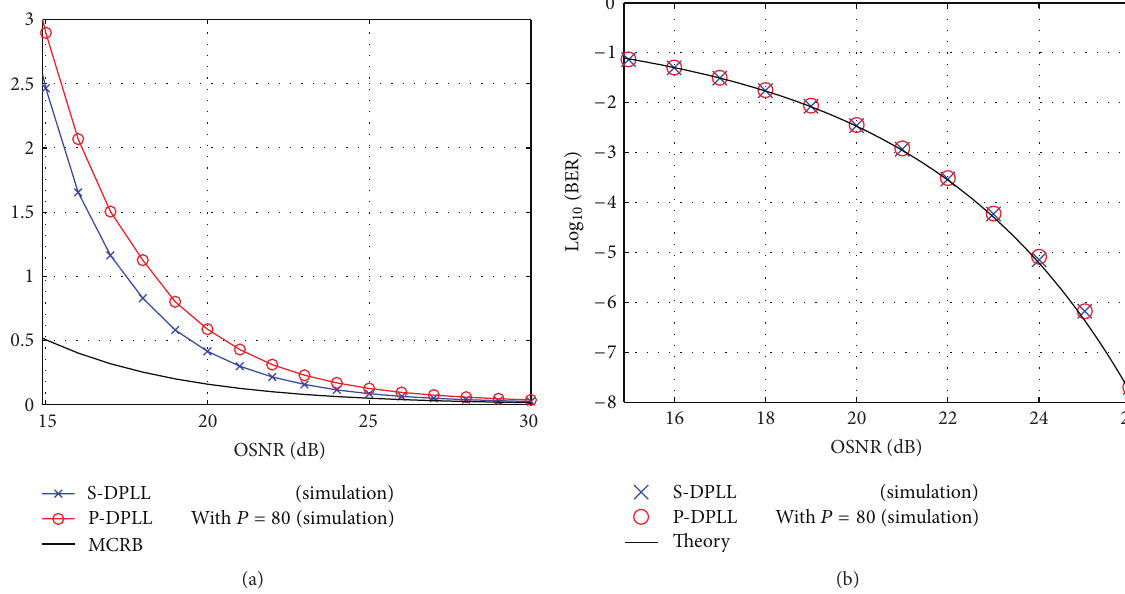
Figure 21: (a) Decision errors impact on the P-DPLL performance against the modified Cramer-Rao lower bound, 1/𝑇 = 32 Gs/s, using 16-QAM scheme. (b) Bit-error-rate of the DPLLs under